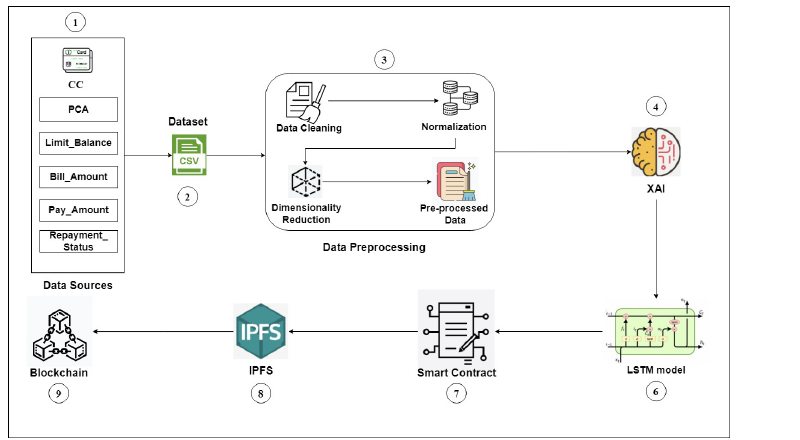
Figure 1. RaKShA : The proposed system flow